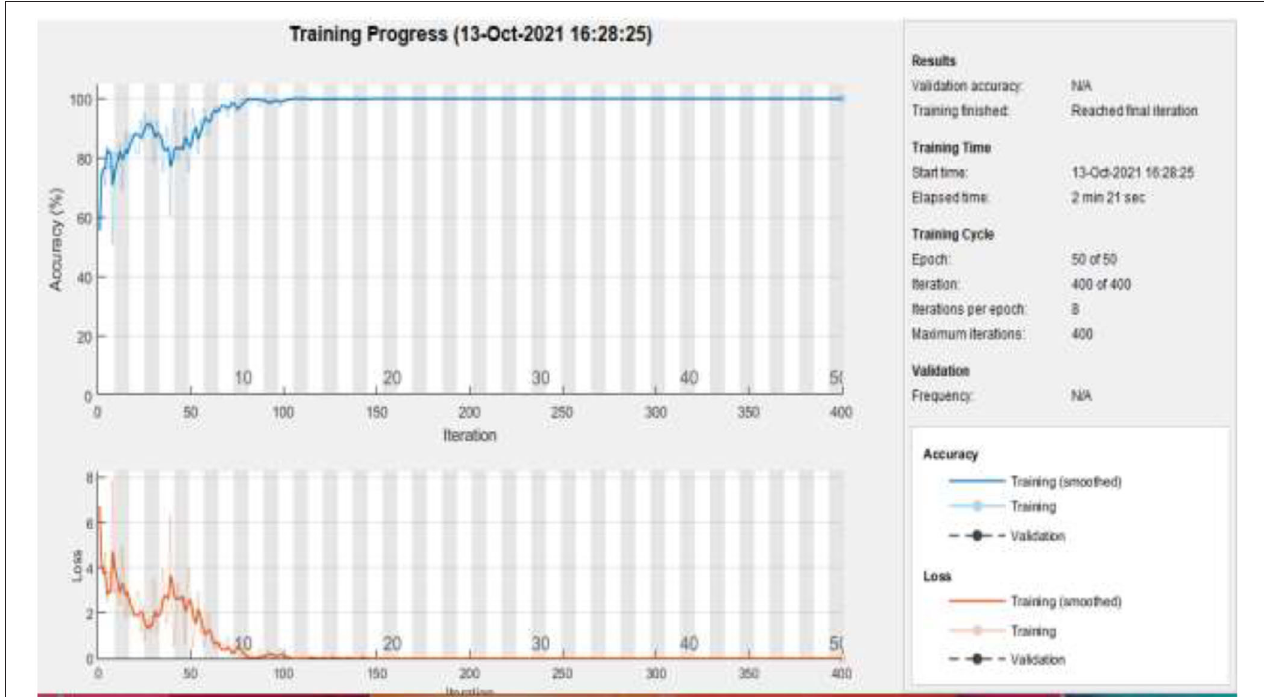
FIGURE 11 | Training of dataset C at 50 epochs.